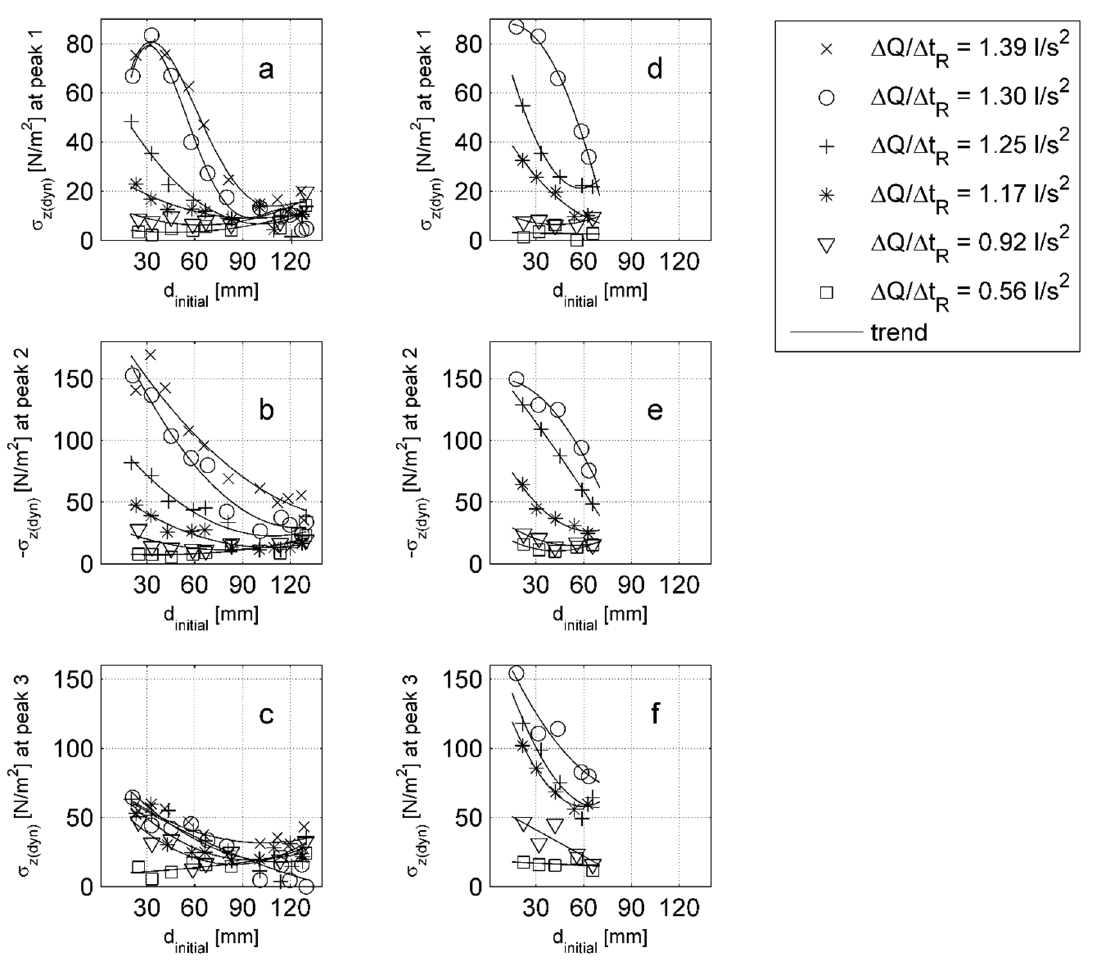
Figure 8. Dynamic lift for each peak and for different ramping rates plotted with trend lines ( a – c) ∆(cid:1843) = 28.6 (cid:1838)/(cid:1871) and ( d – f) ∆(cid:1843) = 57.2 (cid:1838)/(cid:1871) . A higher Δ Q corresponds to a higher Δ d, but Δ d for each experimental run is dependent on (cid:1856) (cid:3036)(cid:3041)(cid:3036)(cid:3047)(cid:3036)(cid:3028)(cid:3039)